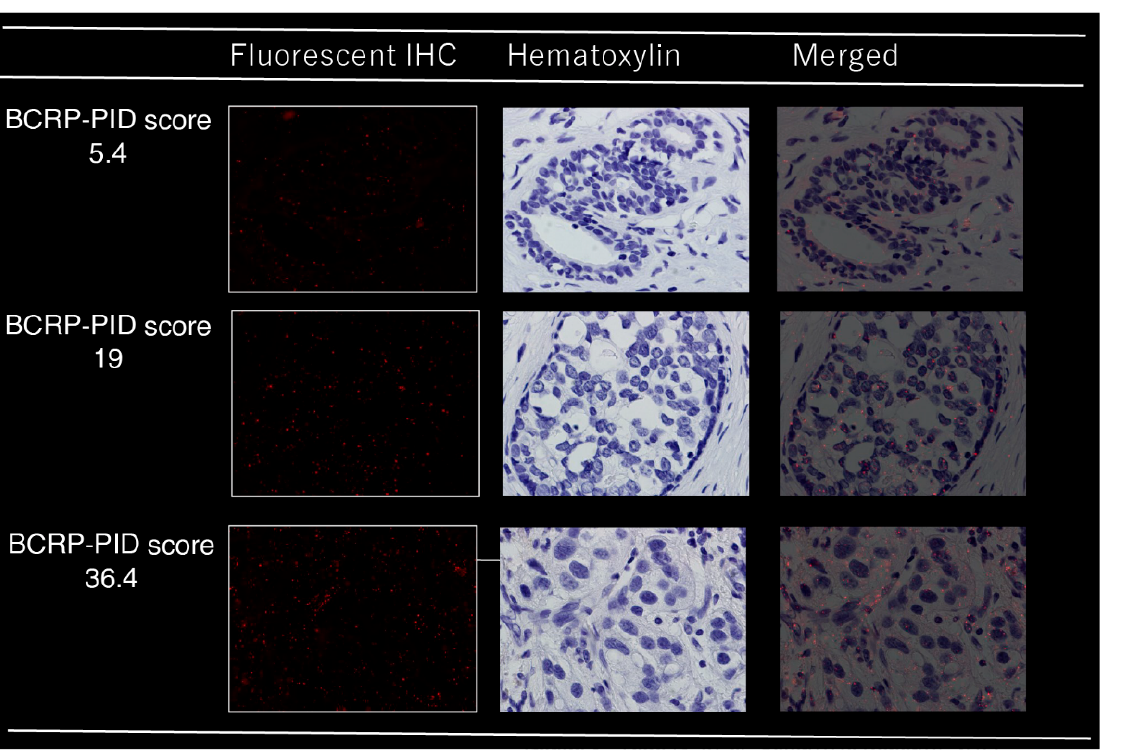
Figure 1. Immunohistochemical analysis of BCRP in breast cancer tissues using phosphor-integrated dot (PID) staining; red spots on tumor cells indicate PID particles.